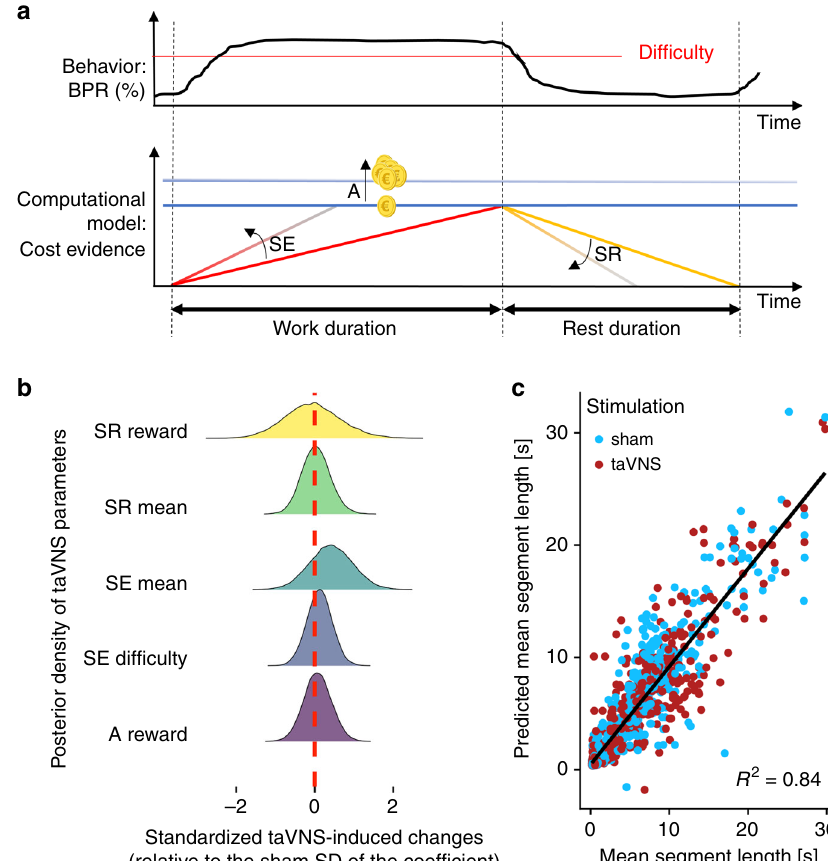
Fig. 6 Vagus nerve stimulation does not affect cost-evidence accumulation. a Schematic summary of the computational model of effort allocation as proposed by Meyniel et al. 34 . b Posterior densities of transcutaneous auricular vagus nerve stimulation (taVNS)-induced changes in the model parameters. The credible intervals of the posteriors all include 0 suggesting that there is no signi fi cant effect on cost-evidence accumulation. c Simulations show that the length of segments can be recovered very well by the fi tted model for both stimulation conditions. Source data for b , c are provided as a Source Data fi